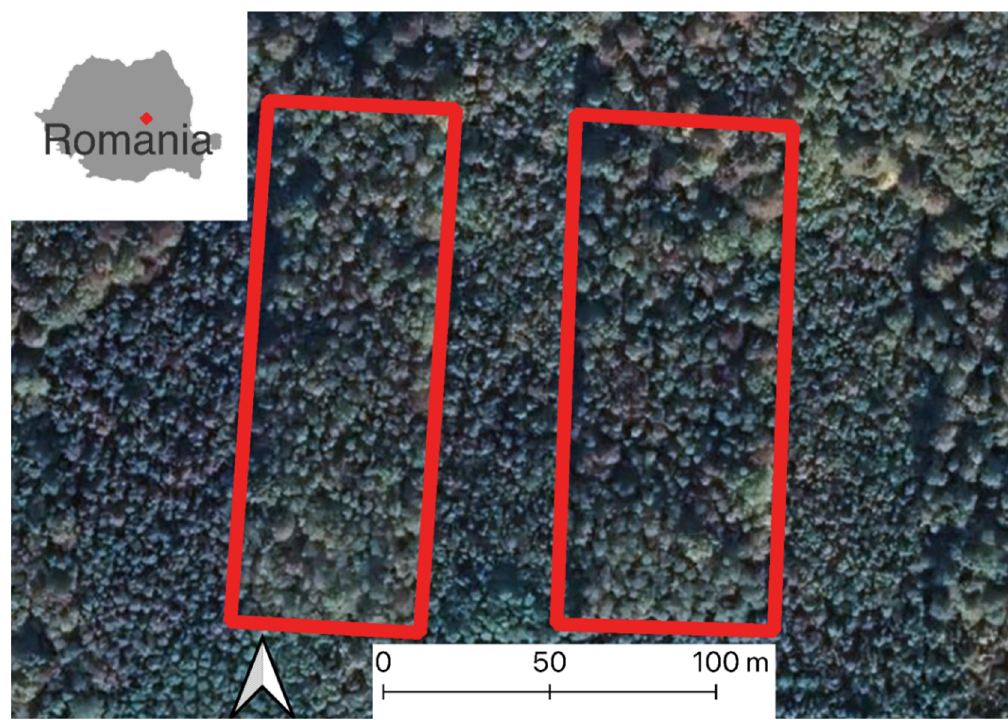
Figure 1 . Study area in 2022. The red rectangle shows the sections on which the measurements were carried out, whereas the red dot in the inset points to the location of the study area within the region, east of Covasna County.